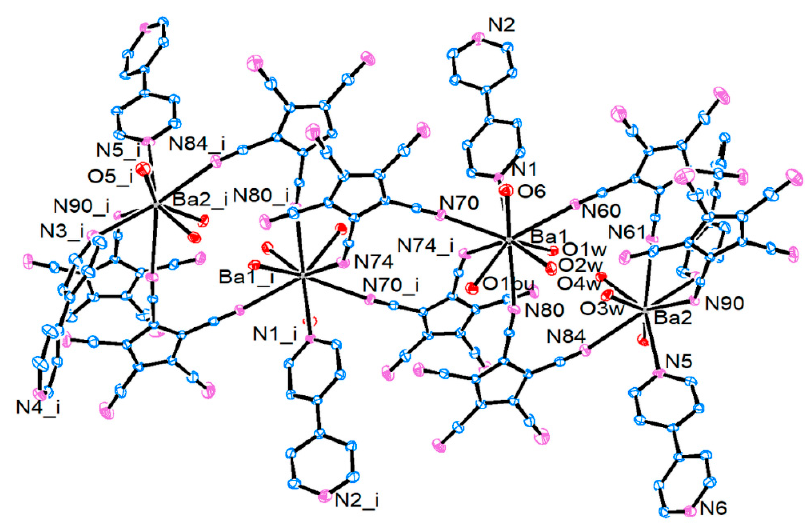
Figure 26 . The tetranuclear unit of compound 6 (H atoms and C 4 H 9 residues of the butanol molecules omitted). Thermal ellipsoids at the 30% probability level.